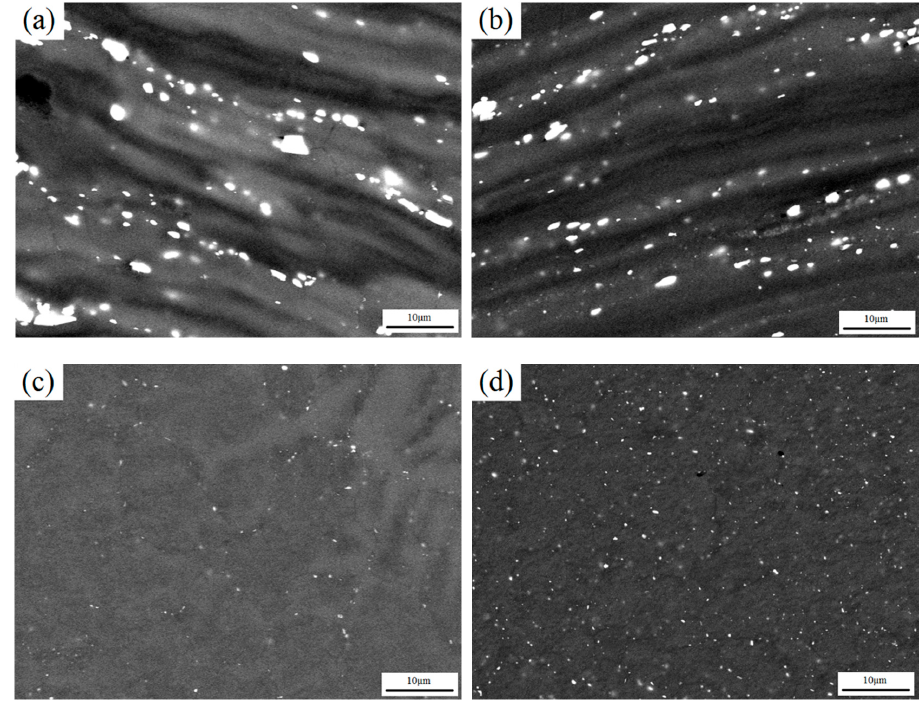
Figure 4. BSE-SEM images of the SZ-2 mm and SZ-4 mm regions of Mg-6Sn samples from FSP: ( a ) SZ-2 mm region of FSP1 sample, ( b ) SZ-2 mm region of FSP2 sample, ( c ) SZ-4 mm region of FSP1 sample, and ( d ) SZ-4 mm region of FSP2